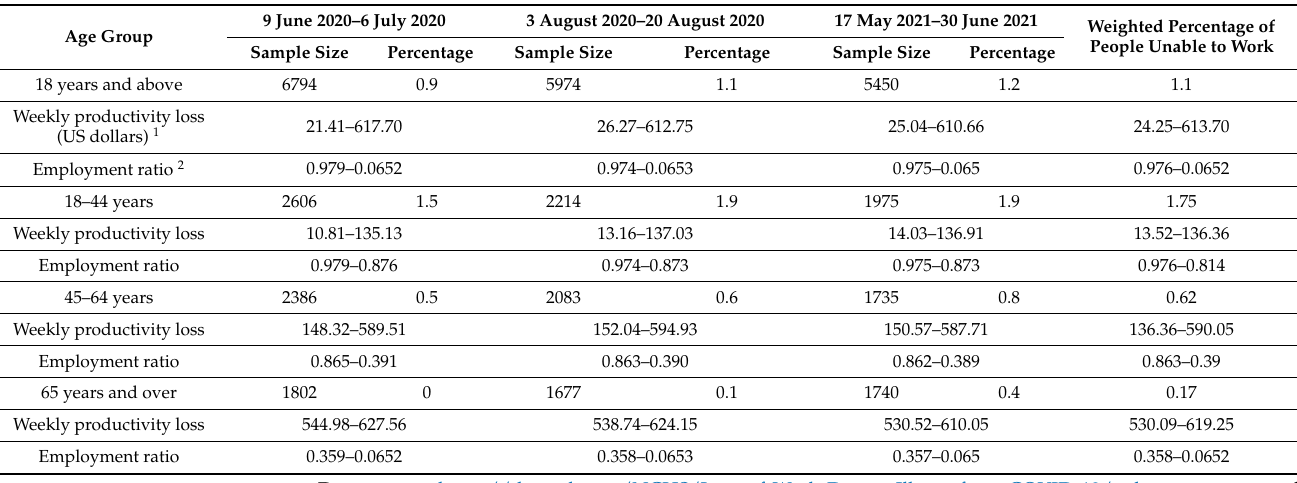
Table 1. Weekly productivity loss and employment ratio of the group unable to work due to self or a family member with COVID-19 relative to the healthy